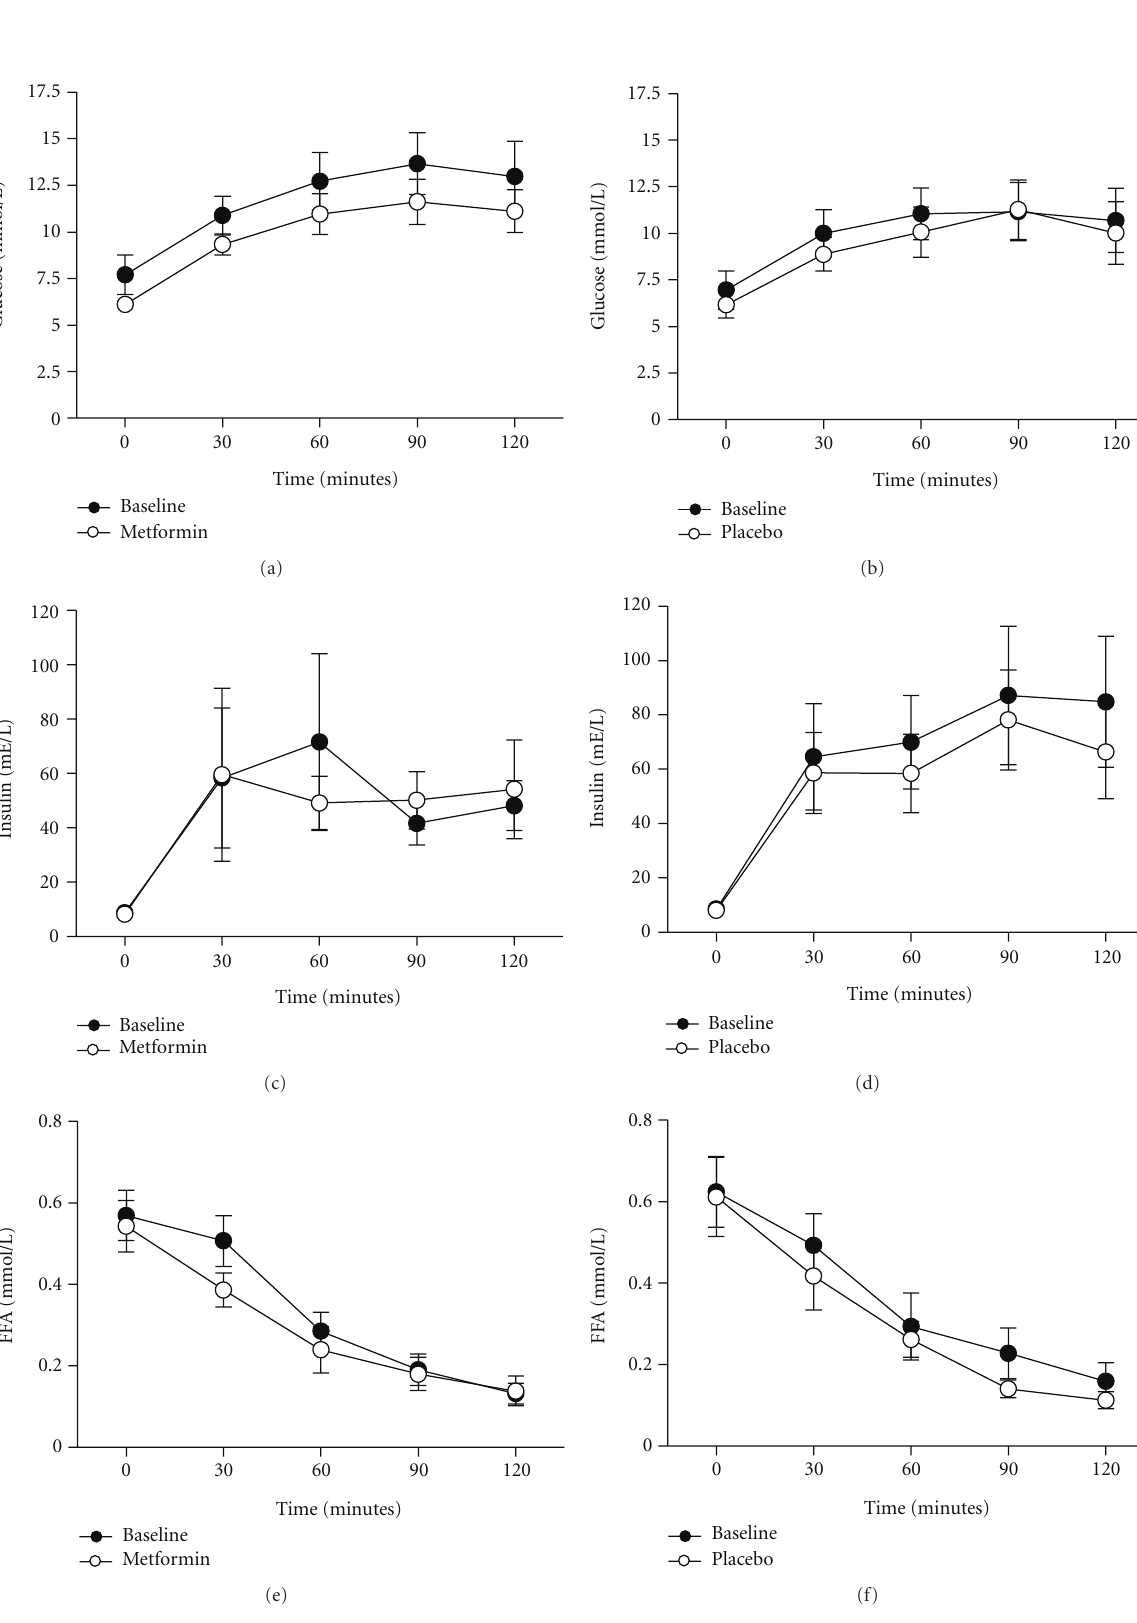
Figure 2: Mean change in glucose, insulin, and free fatty acid (FFA) concentrations during an oral glucose tolerance test (OGTT) in insulin resistant patients at baseline and six weeks after treatment with either metformin ( N = 10) (a, c, and e) or placebo ( N = 9) (b, d, and f). Data represent the mean ±